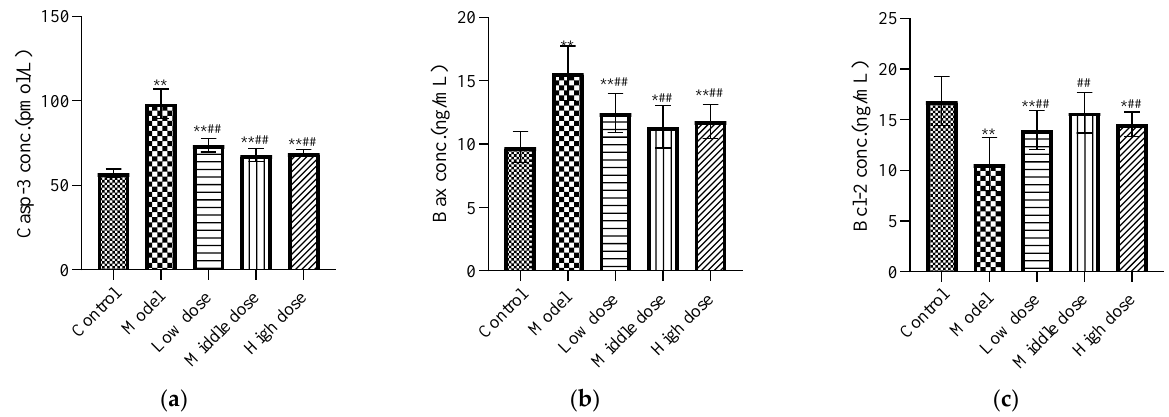
Figure 5. Effects of LBP on apoptotic biomarkers. The results are expressed as the mean ±SD, n = 10. * Statistically significant compared to control group, * p < 0.05, ** p < 0.01. # Statistically significant compared to model group, # p < 0.05, ## p < 0.01. ( a ) Expression of caspase-3 (Casp-3); ( b ) Expression of Bax; ( c ) Expression of Bcl-2.